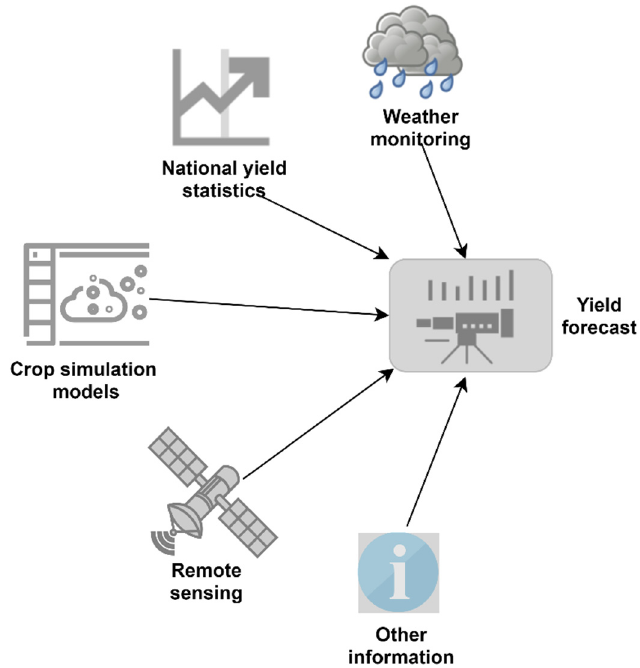
Figure 1. Crop yield estimation methods.